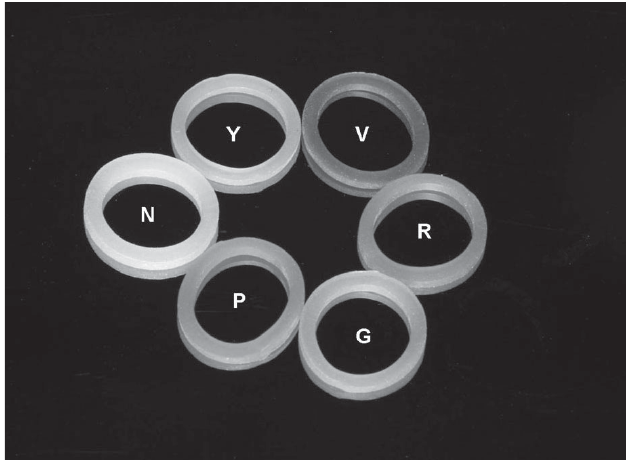
Fig. 1: Latex intraoral elastics evaluated in this study: N, Y, V, R, G and P (Uniden, natural latex elastics and colored elastics, namely, yellow, violet, red, green and pink,